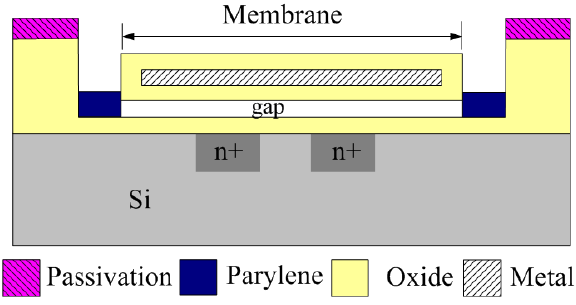
Figure 2. Schematic cross-sectional view of a sensing